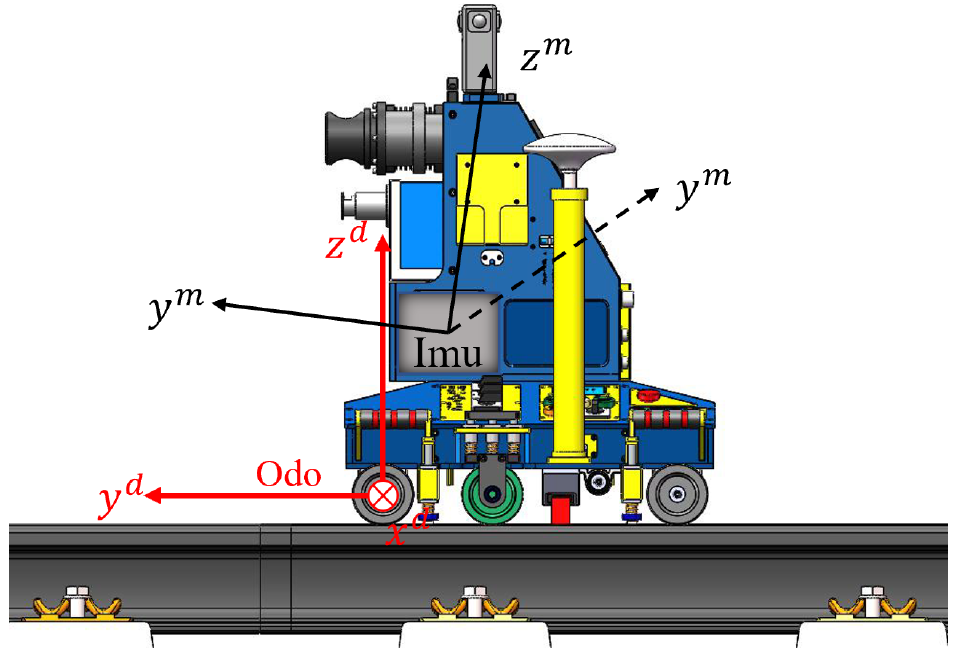
Figure 8. Installation declination error of the odometer coordinate system and the inertial navigation coordinate system.